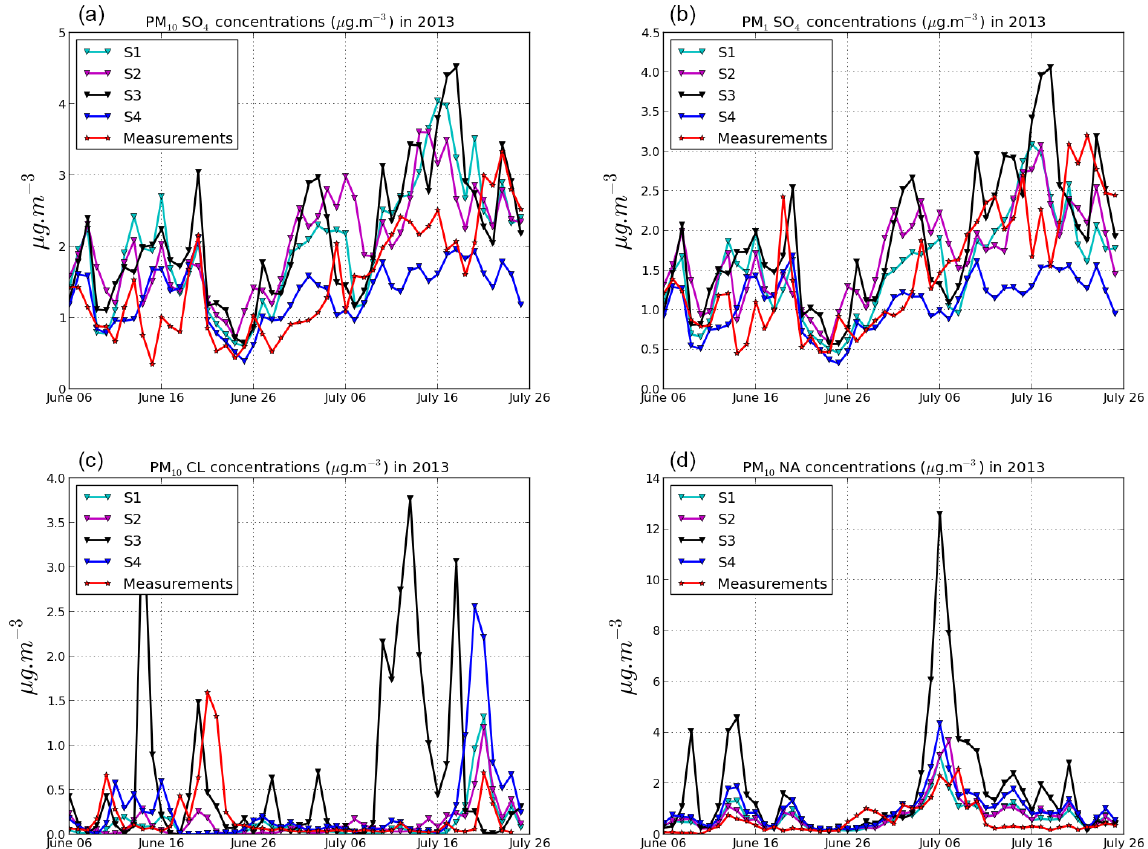
Figure C2. Comparisons of simulated and observed PM 10 sulfate (a) , PM 1 sulfate (b) , PM 10 chloride (c) and PM 10 sodium (d) concentra- tions at Ersa during the summer